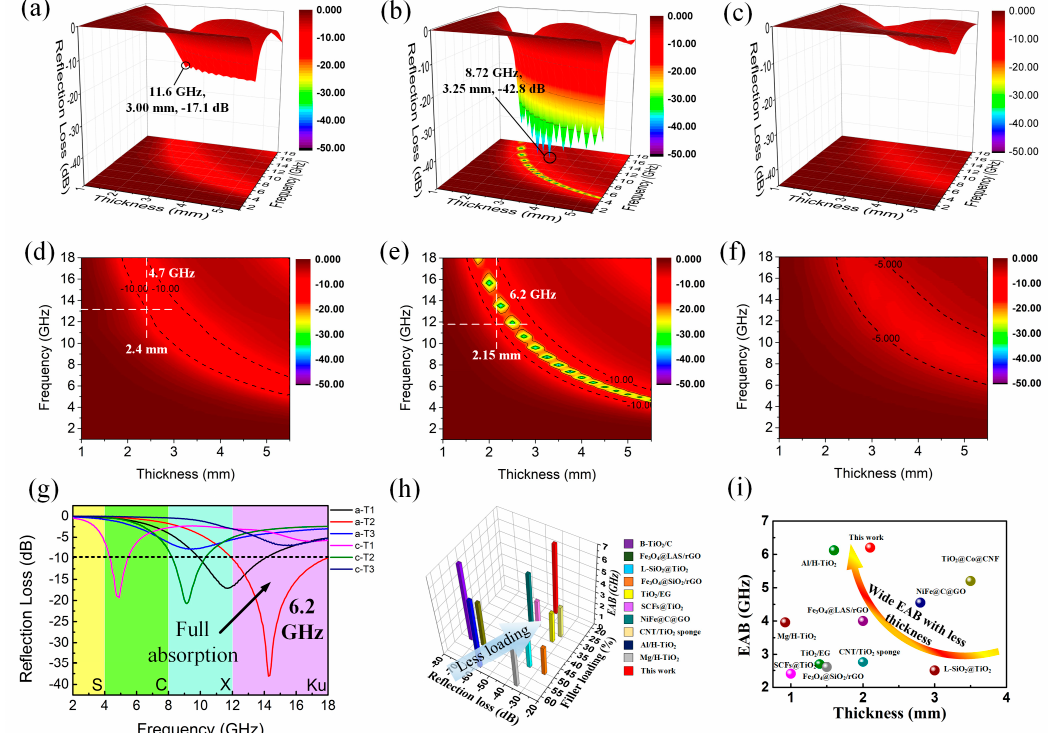
Figure 4. 3D RL and 3D projection plots of ( a , d ) a-T1, ( b , e ) a-T2 and ( c , f ) a-T3; ( g ) the maximum EABs of the TiO 2 / rGO composites; comparison of ( h ) the filler loading and ( i ) the matching thickness of the maximum EAB with graphene- and TiO 2 -based absorbers reported in other